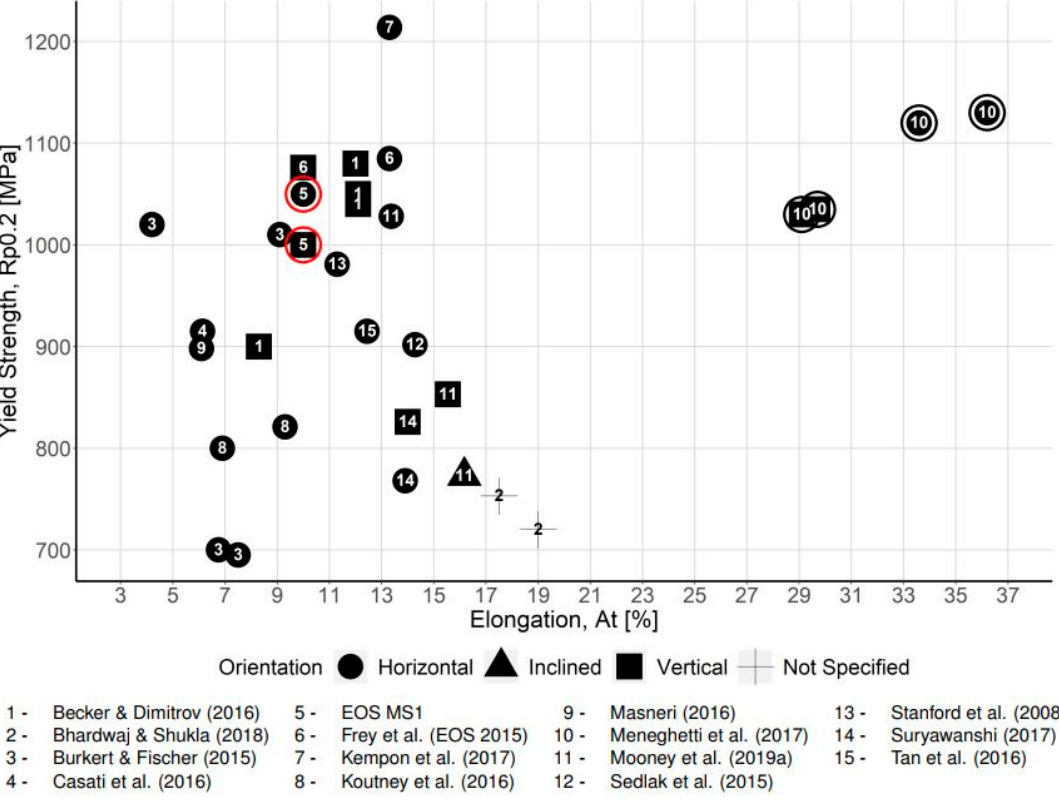
Figure 6. Comparison of the as-built yield strength (Rp0.2) and %elongation (At) properties by AM build-orientation for maraging steel 300 test-specimens fabricated using various geometries, processing parameters, scan strategies, and powder feedstock types.